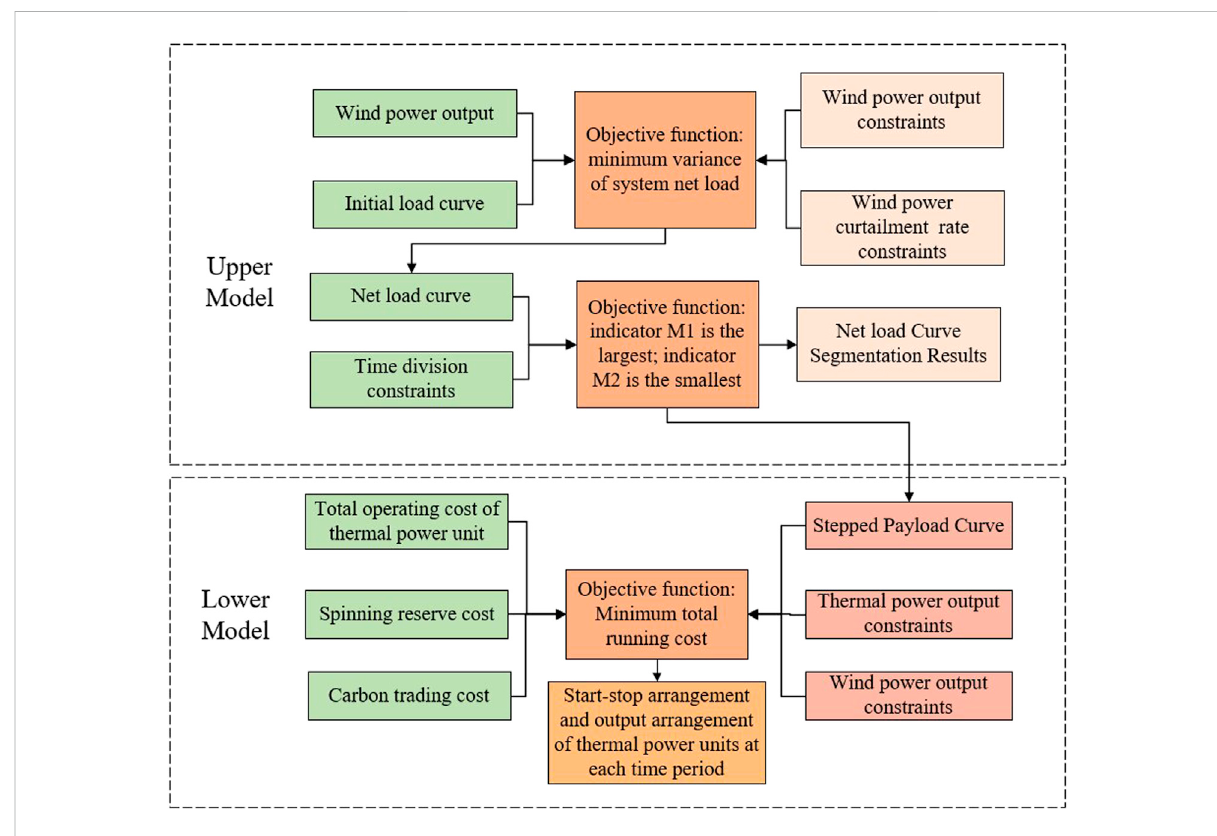
FIGURE 2 Structure diagram of the double-layer optimization mode.